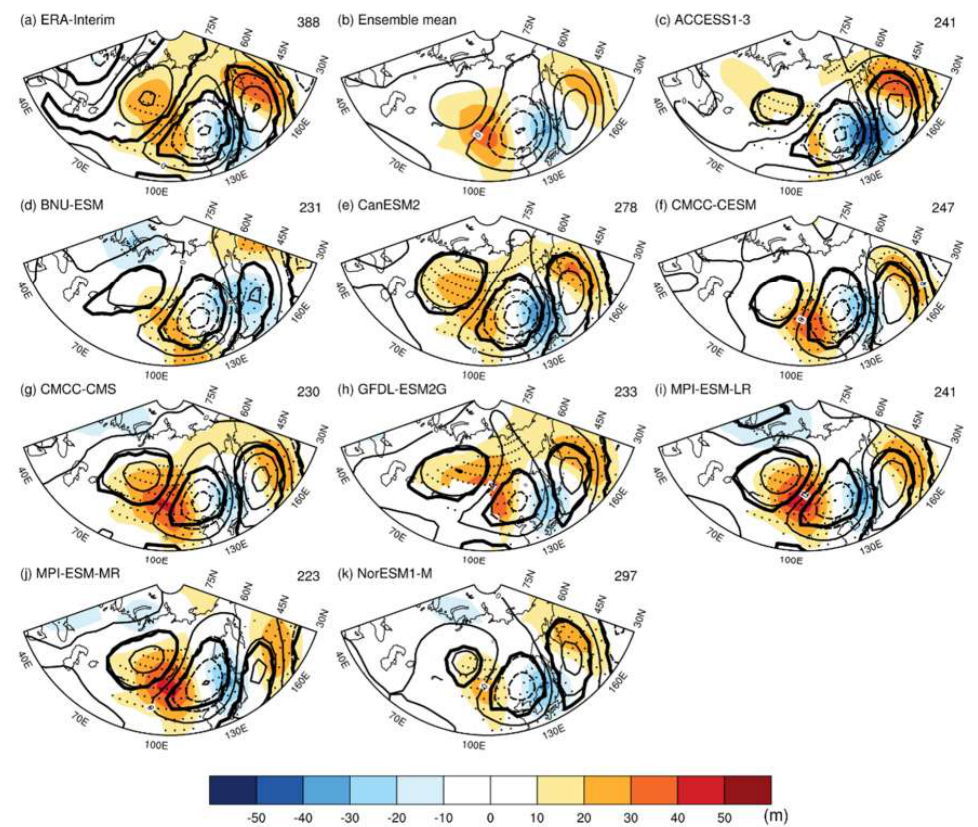
Figure 2. Composite of geopotential height anomalies at 250 hPa (contour interval of 30 m; values significant at the 99% confidence level are represented by thick lines) and at 850 hPa (shading; values significant at the 99% confidence level are represented by black dots) for cold surge occurrence dates identified in the ERA-Interim data, the output of the nine CGCMs for the historical run, and the ensemble mean of the CGCMs for the historical run. The number of CS occurrences for composite are represented on the top-right of each panel.